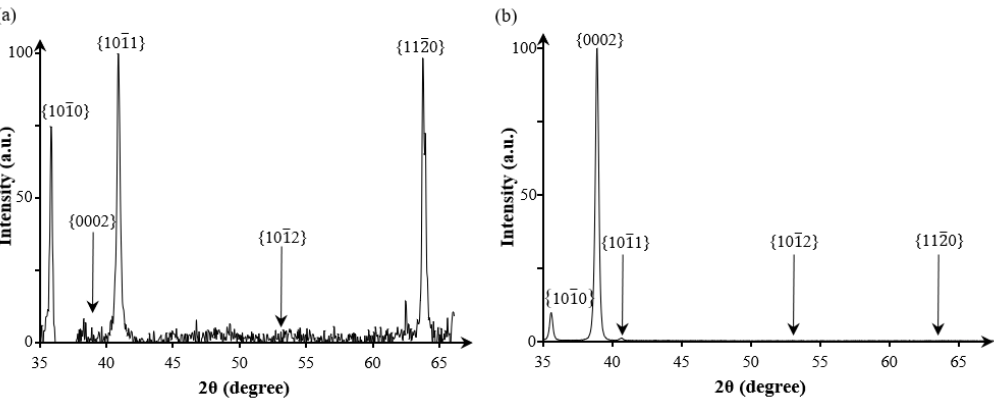
Figure 6. ( a ) XRD intensity as a function of angle 2 θ for ( a ) Ti nanorods, ( b ) Ti polycrystalline thin film deposited with incidence angle of 0° and substrate temperature of 523K, and the other conditions are the same as for the nanorods.